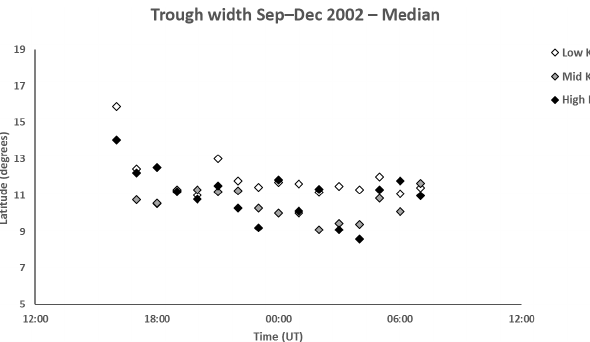
Figure 5. Median trough widths from 16:00 to 07:00UT for low Kp (0 to 2 + ) , medium Kp (3 − to 4) and high Kp ( ≥ 4 + ) . The represen- tative interquartile range is approximately 2.5 ◦ latitude. Between 21:00 and 04:00UT, the trough width, of 11–13 ◦ latitude, for the low Kp is generally larger than for the other geomagnetic activity series.